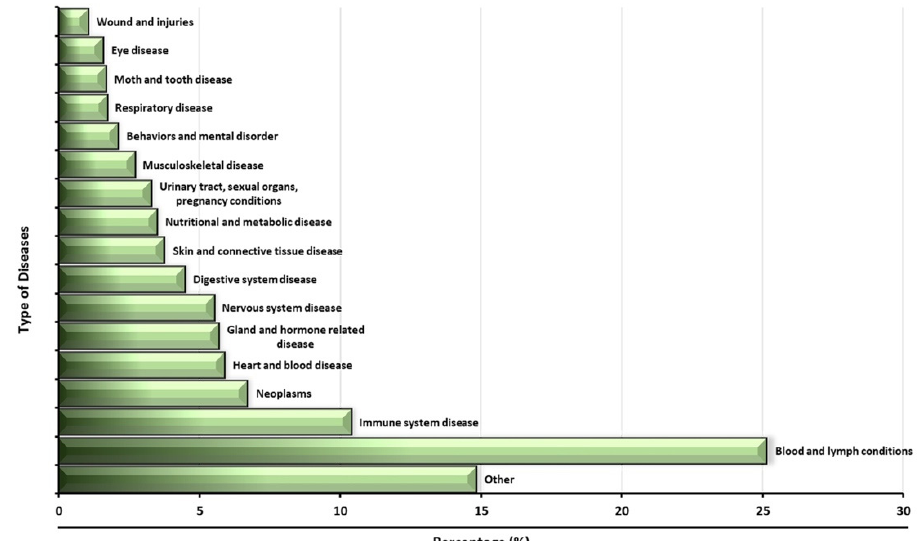
Figure 2. Diseases considered in clinical trials using stem cells. Autologous vs. Allogenic: Stem-cell-based products for use in clinical trial studies can be divided into two categories: autologous and allogeneic stem cells. In autologous